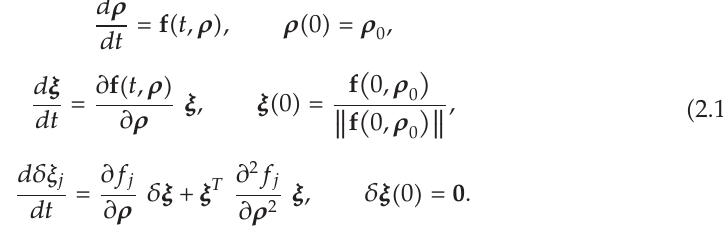
Figure 1 (cid:3) a (cid:4) shows the PSS (cid:3) dark blue points (cid:4) and the chaos indicator OFLI2 (cid:3) di ff erent color regions, red color for chaotic behavior and blue color for regular one (cid:4) for x (cid:8) 0 and E (cid:8) 1 / 8. Both techniques give complementary information about the behavior of the system. Black circles sign two periodic orbits selected for the correction process. The left point corresponds to an unstable periodic orbit and the right point to a stable one. On the